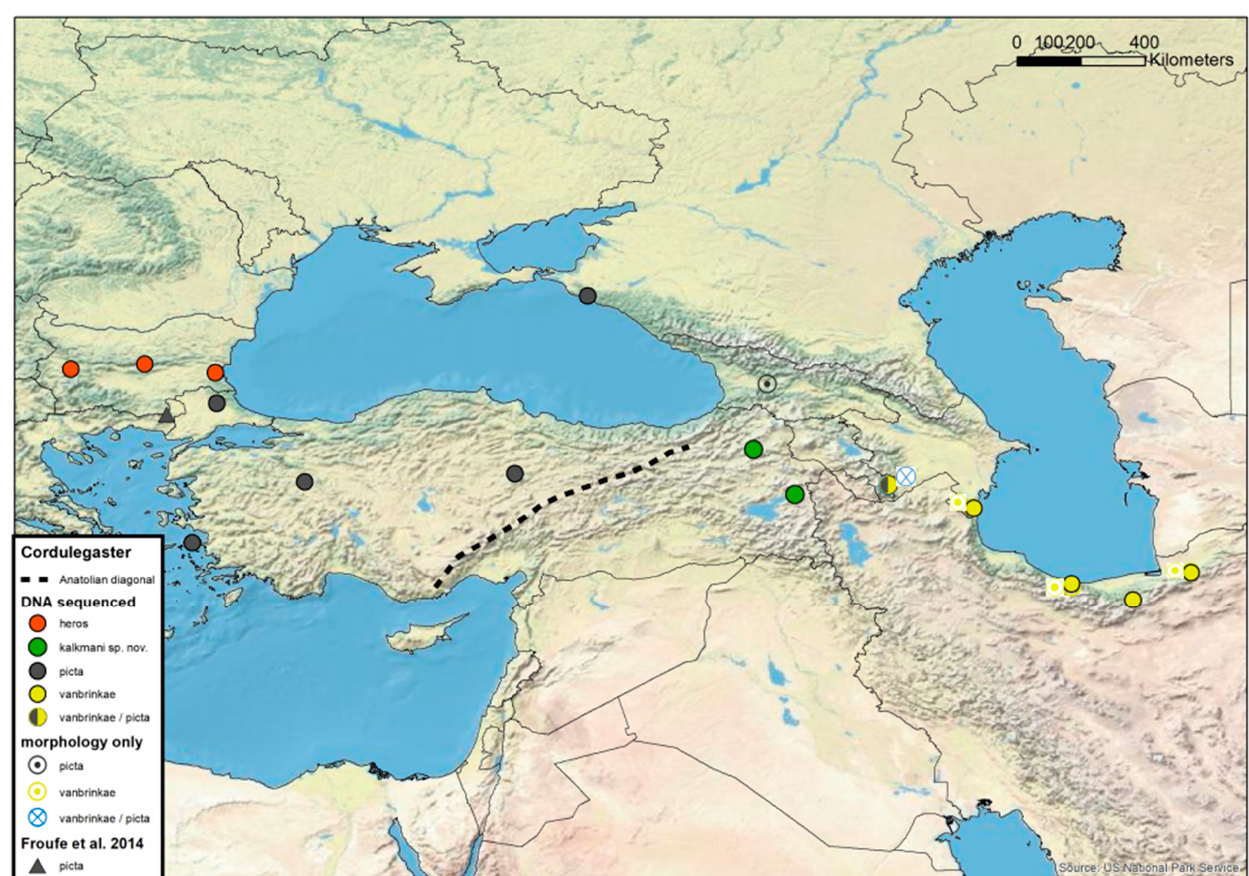
Figure 21. Map with species identified in this study for C. boltonii -group relative to the Anatolian Diagonal.